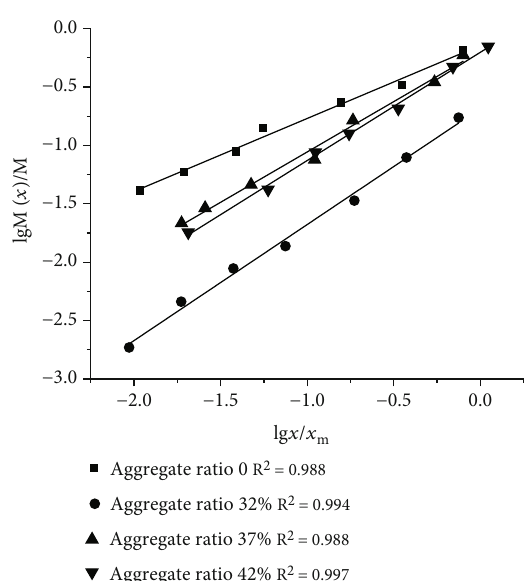
Figure 4: lg M ð x Þ / M − lg x / x